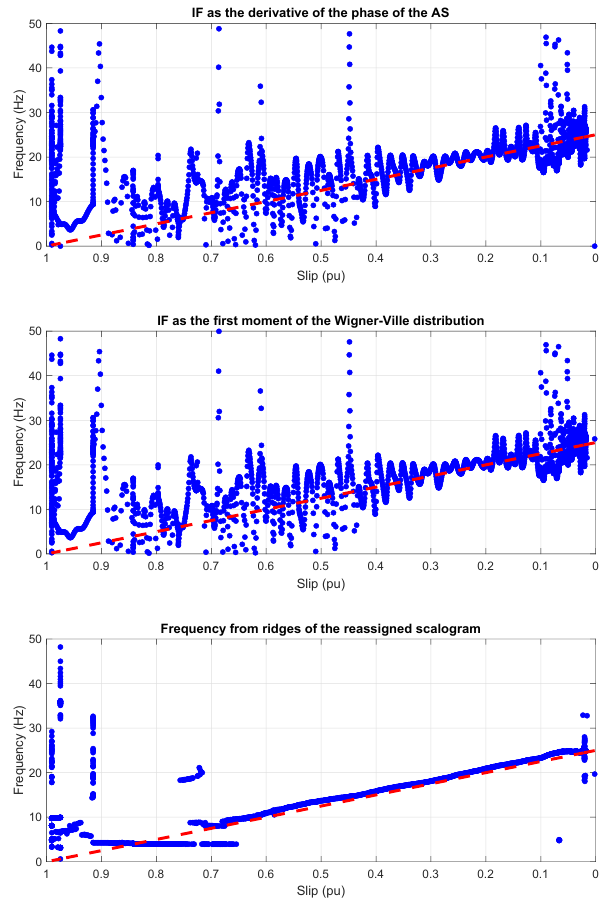
Figure 19. Instantaneous frequency versus slip of the main eccentricity components in a tested start-up calculated by means of (from top to bottom): Hilbert transform, Wigner–Ville distribution, and the scalogram based on the CWT. Dashed, red line: theoretical evolution of the fault harmonic. Blue dots: evolution of the fault harmonic of the experimental